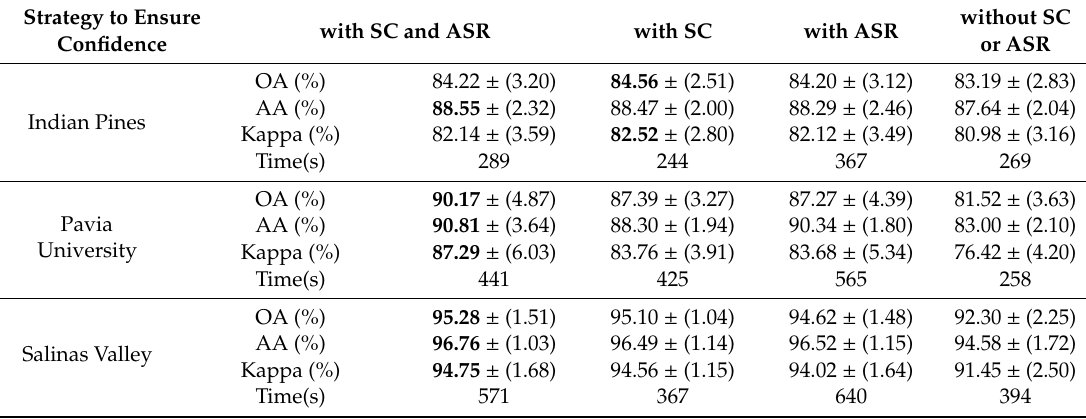
Table 4. OA, AA, kappa (as a percentage, with the standard deviation in brackets), and running time average statistics obtained by using different strategies to ensure confidence for three datasets.